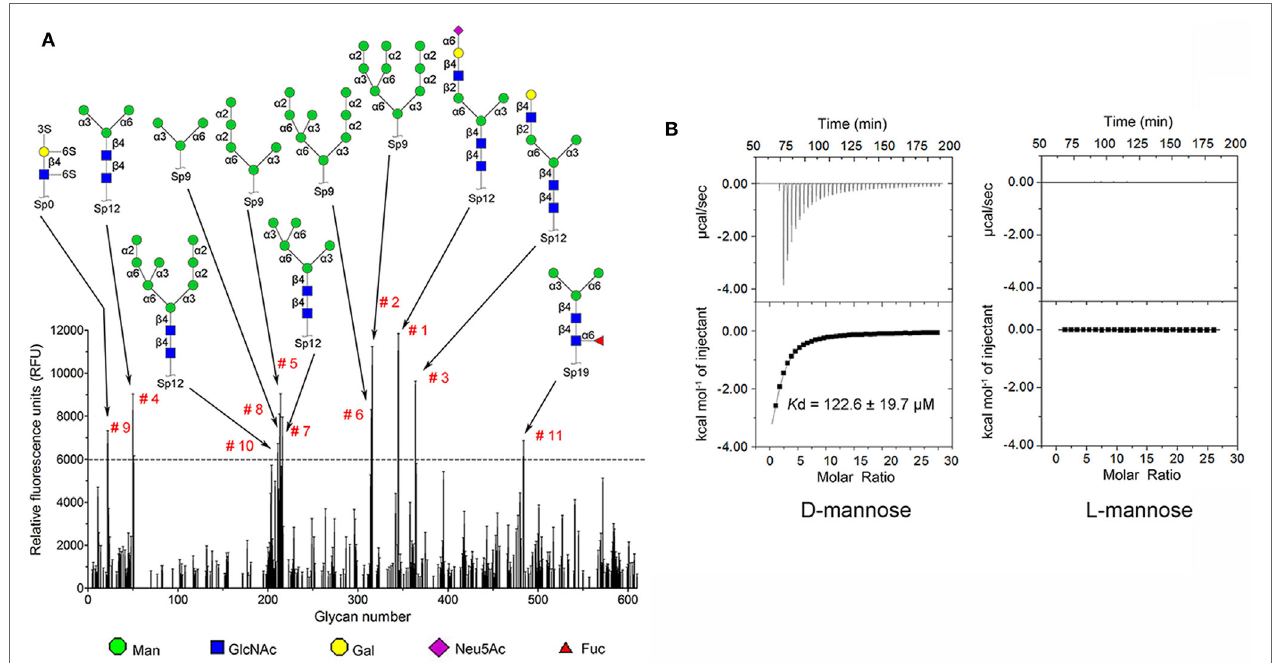
FigUre 1 | Recombinant Crassostrea gigas DM9 domain containing protein 1 (rCgDM9CP-1) exhibited high binding specificity and avidity to d -mannose. (a) Glycan microarray analysis (V5.1) was performed to detect the carbohydrate binding specificity. Glycan structures with highest relative fluorescence unit (RFU) are depicted for epitopes. The raw data and the entire list of glycans are available on the consortium for functional glycomics (CFG, http://www.functionalglycomics. org/) website or in Table S2 in Supplementary Material. (B) The binding of rCgDM9CP-1 to d -mannose and l -mannose was determined by isothermal titration calorimetry. Upper panel: data obtained from injections of carbohydrate into the protein-containing cell. Lower panel: plot of the total heat released as a function of ligand concentration for the titration shown above (squares). The continuous line represented the best least-squares fit to the obtained data.